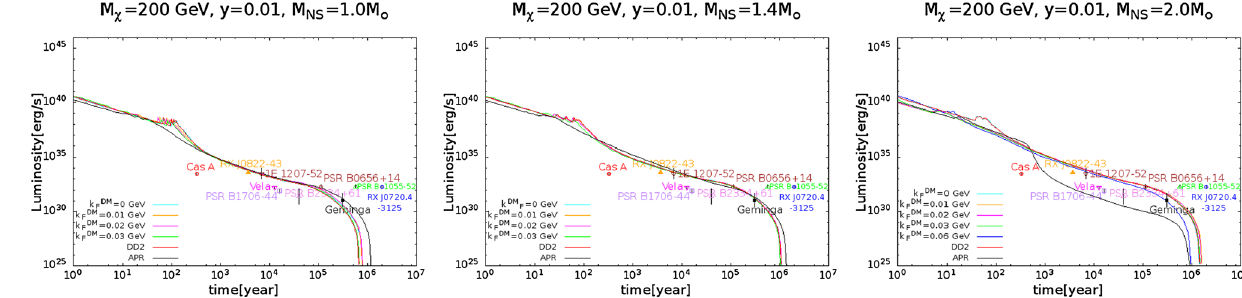
Fig. 4 Variation of luminosity with time three differently chosen NS masses M NS = 1 . 0 M (cid:8) (Left panel), M NS = 1 . 4 M (cid:8) (middle panel), M NS = 2 . 0 M (cid:8) (right panel) with varying k DM M χ = 50GeV in each panel. The theoretical calculations are compared